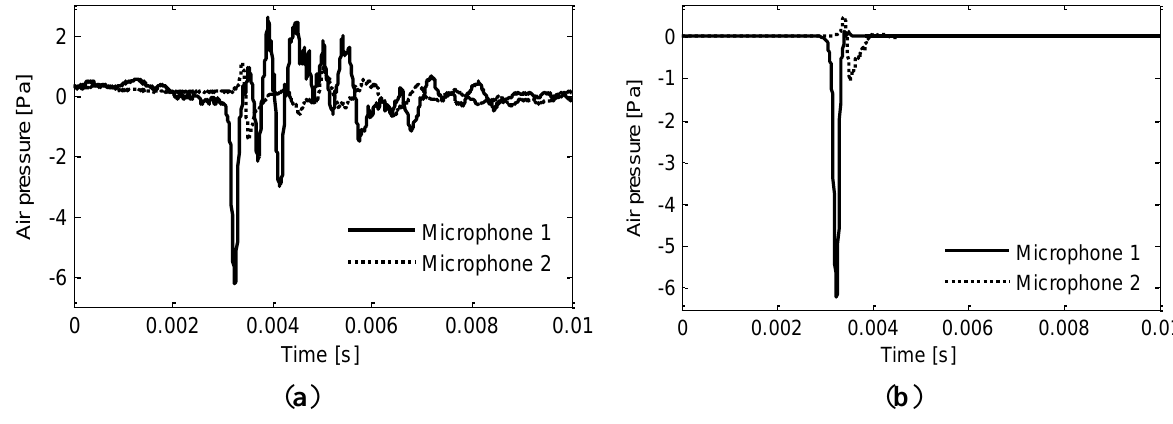
Figure 14. Microphone data of parking lot test: ( a ) Raw acoustic data; and ( b ) Filtered radiating surface